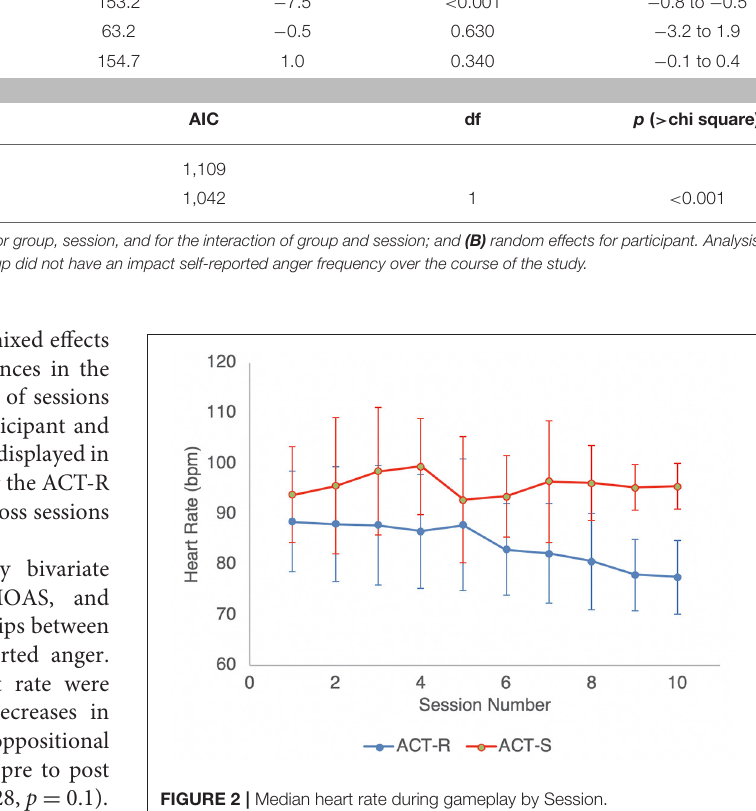
FIGURE 2 | Median heart rate during gameplay by